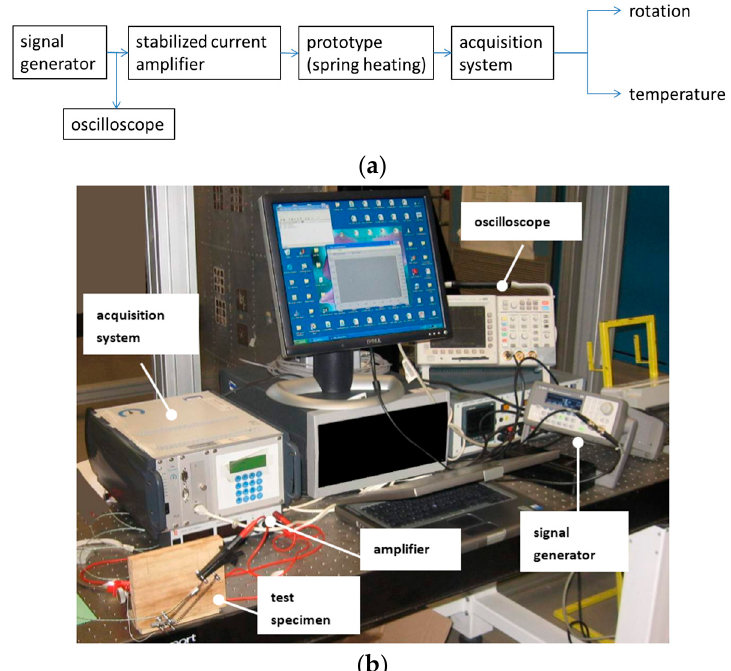
Figure 12. Setup diagram ( a ); instrumentation ( b ) for the experimental characterization of the SMA